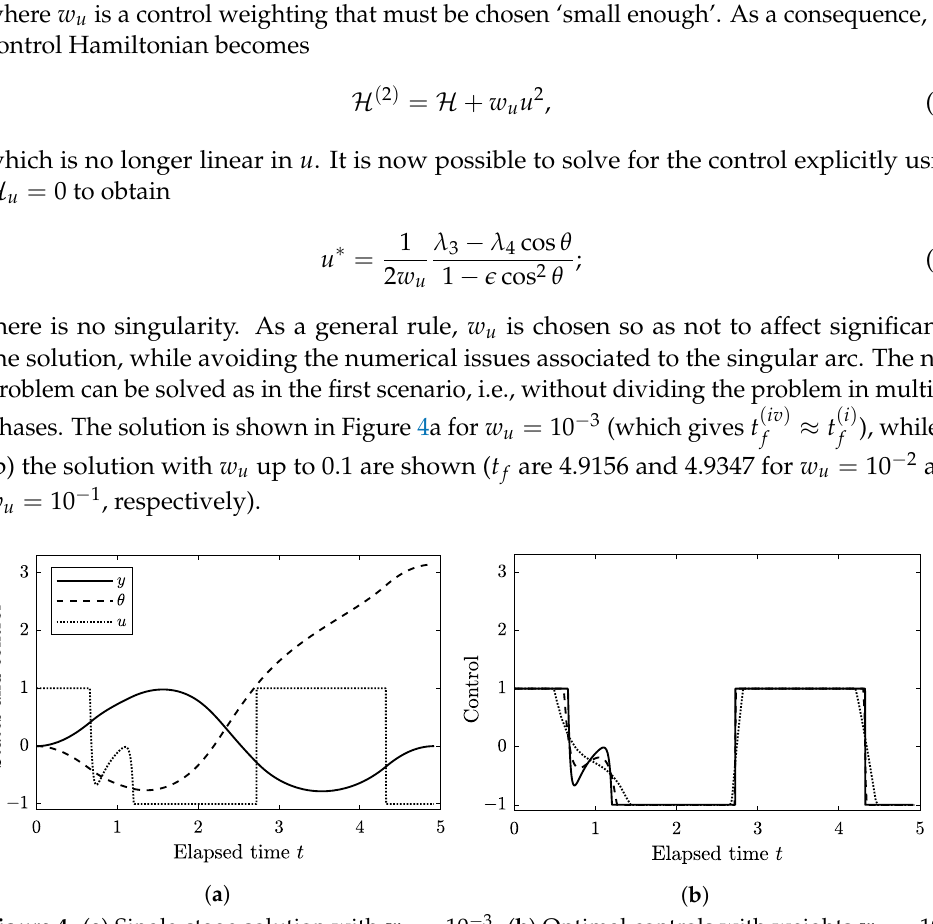
Figure 4. ( a ) Single-stage solution with w u = 10 − 3 . ( b ) Optimal controls with weights w u = 10 − 3 (solid), w u = 10 − 2 (dashed), and w u = 10 − 1